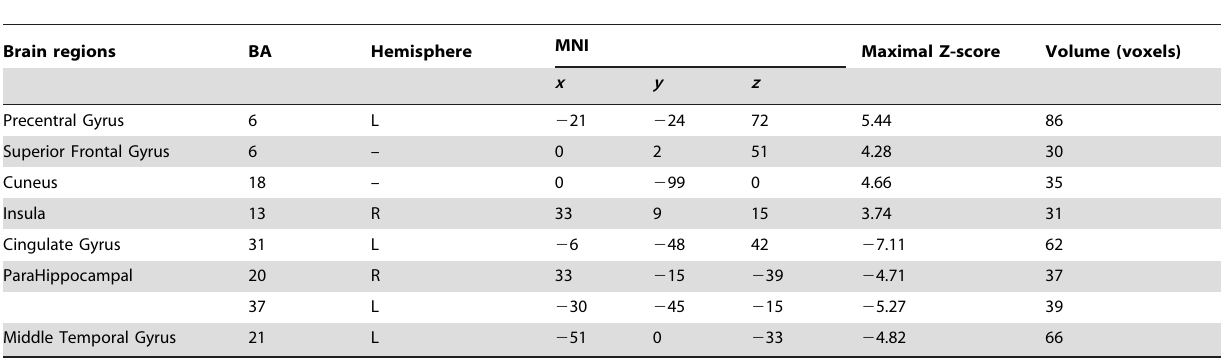
Table 3. Brain areas with significant different ReHo values between MCI patients and healthy controls during the resting state at P , 0.01 (Alphasim corrected, p , 0.01, 30